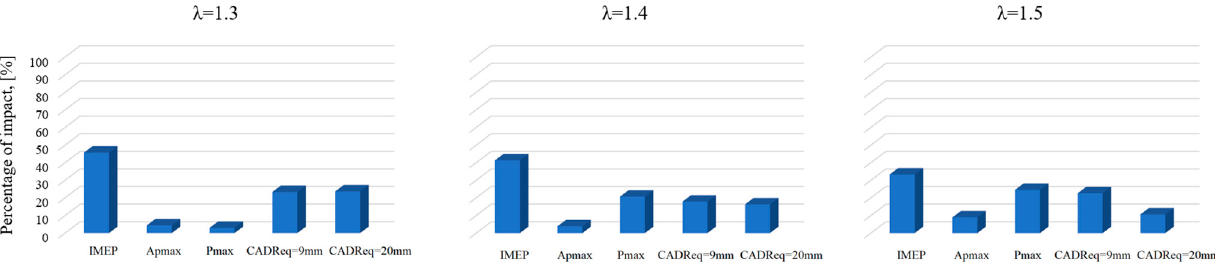
Figure 14. Global interpretation of the feature importance.